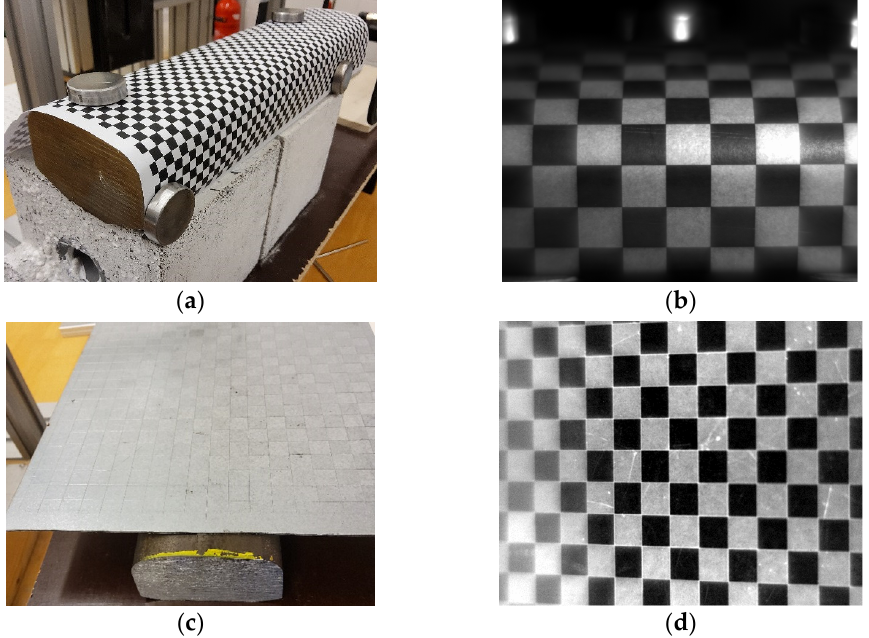
Figure 4. ( a ) Paper grid wrapped around a rail piece; ( b ) calibration image of the paper grid recorded by the IR camera; ( c ) metallic grid on top of a rail piece; ( d ) IR calibration image of the metallic grid.